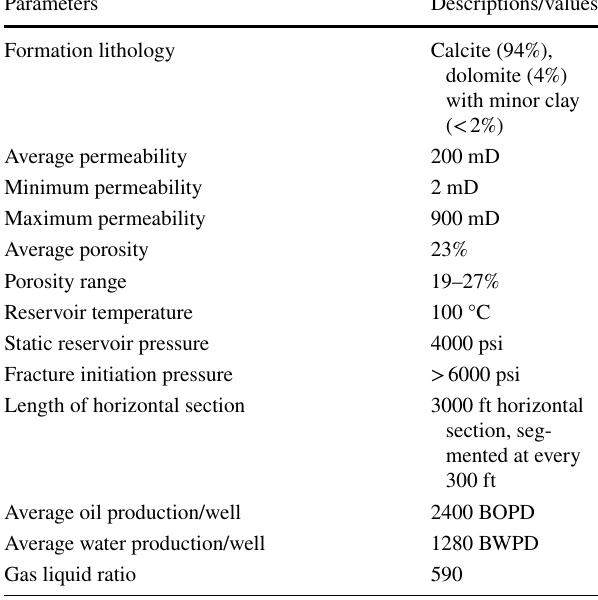
Table 1 Well and reservoir